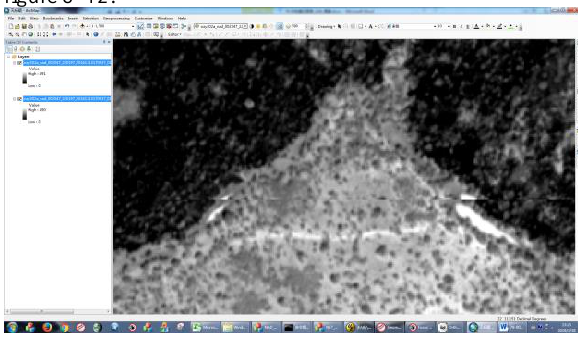
Figure 8. The accuracy of plane edge connection exceeds